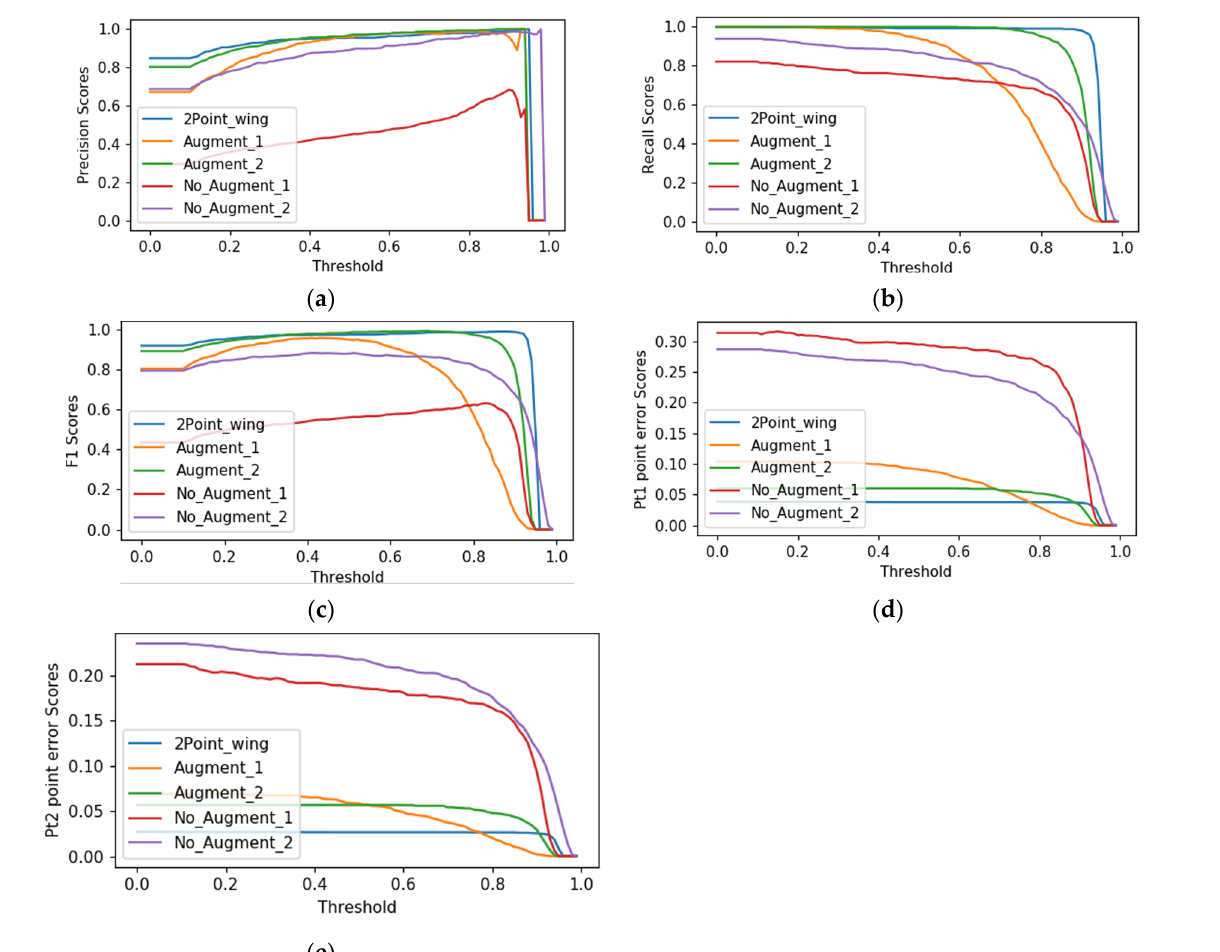
Figure 7. Results of two-step identification algorithm for the EnglishLP database: ( a ) precision scores; ( b ) recall scores; ( c ) F1 scores; ( d ) Pt1 point error scores; ( e ) Pt2 point error scores. The proposed algorithm read and processed all generated data in TFRecord. The last were reinitialized, and the network was retrained based on the CenterNet training